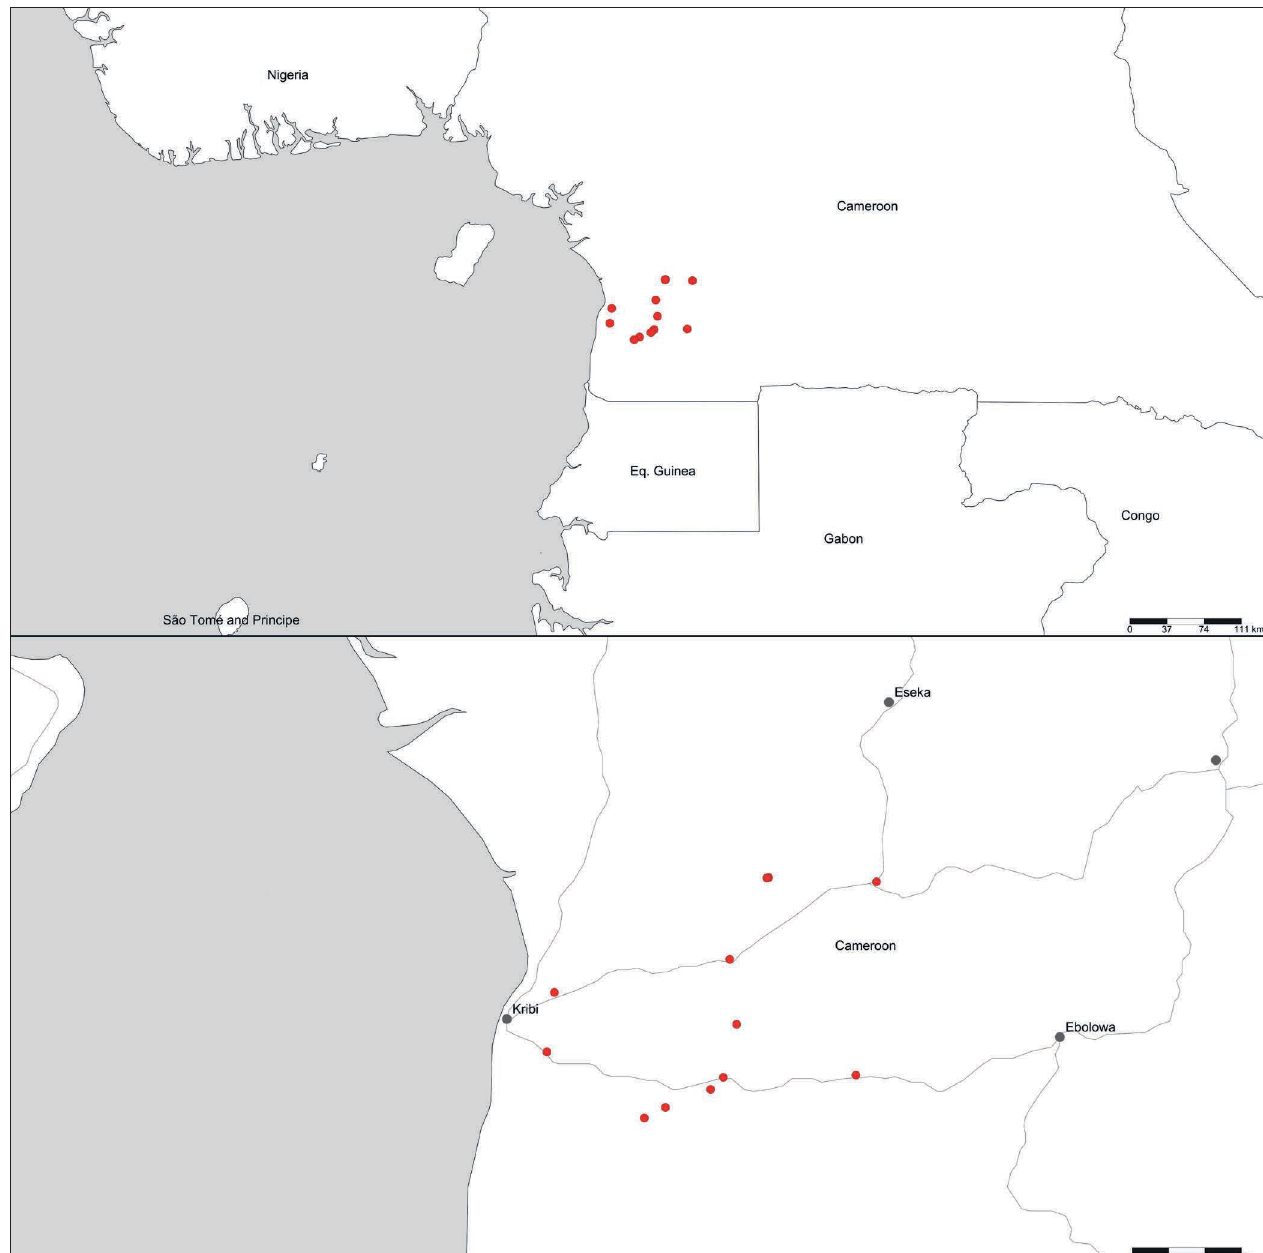
Figure 4 – Distribution maps of J. gigantophylla (top: long range; bottom: close